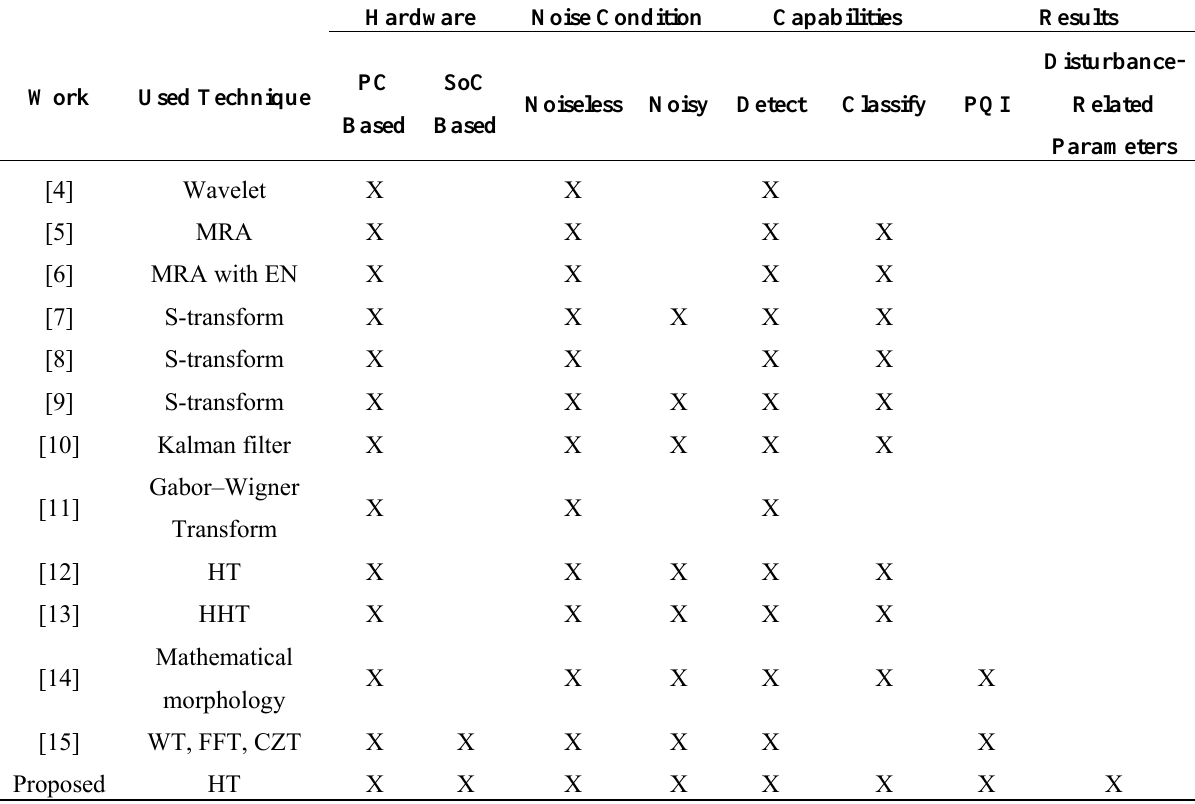
Table 9. Main characteristics of previous works and of the proposed